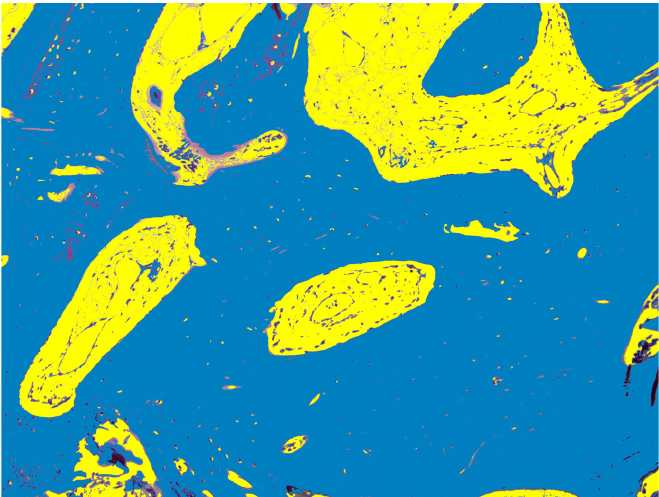
FIGURE 2 - The same histologic section prepared for histometry. The bone tissue was marked in blue and the soft tissue in yellow. Then the percentage of bone tissue was measured using the Image Pro Plus 6.1